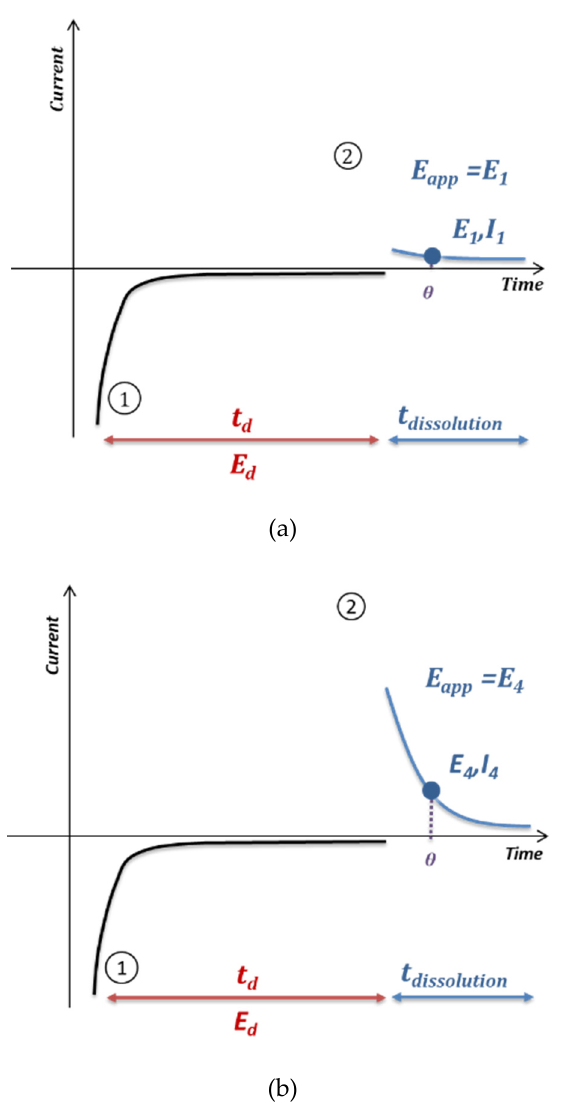
Figure 5. Cont Figure 5. Cont.